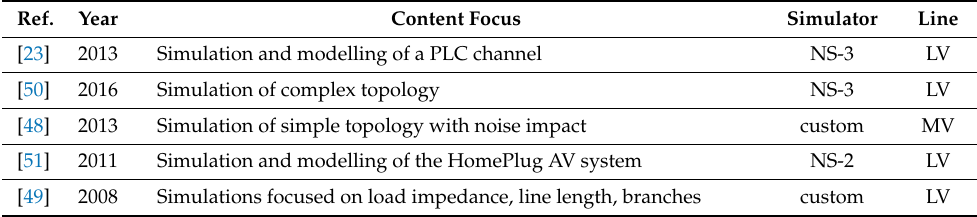
Table 2. Papers dealing with simulations with focus on the line type. Ref.